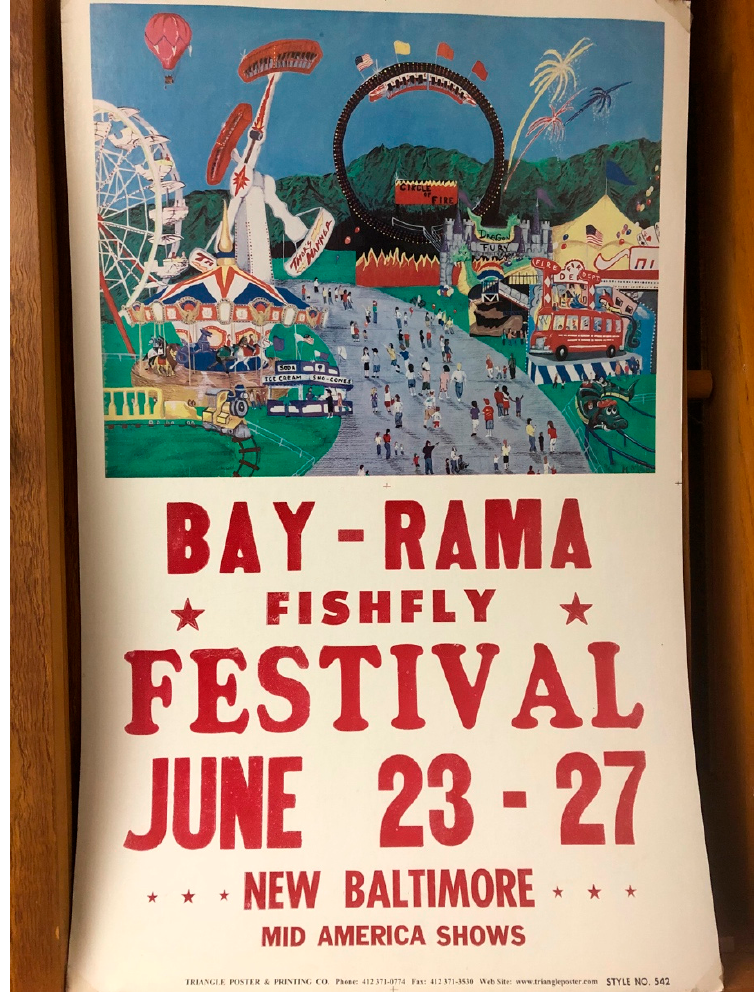
Figure 13. Advertising poster from “fishfly” festival in New Baltimore, Michigan, USA, ca. 2004. The annual celebration usually coincides with the mass emergence of Ephemeridae from Lake Saint Clair, which is located on the Michigan, USA and Ontario, Canada borderline.